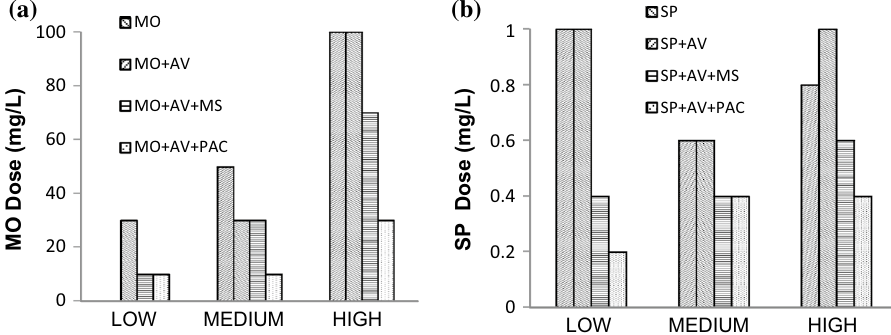
Fig. 7 Effect of AV and ballast- ing agents on dose of a MO , and b